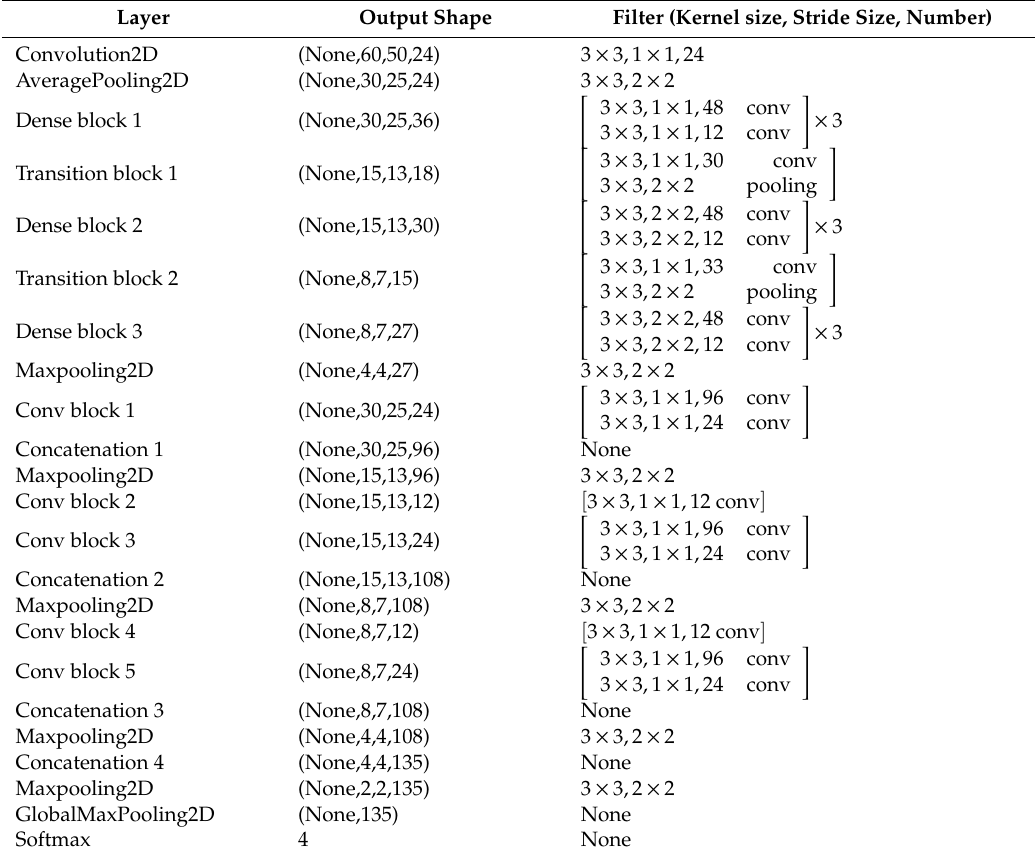
Table 5. The network architecture of our MDD-Net